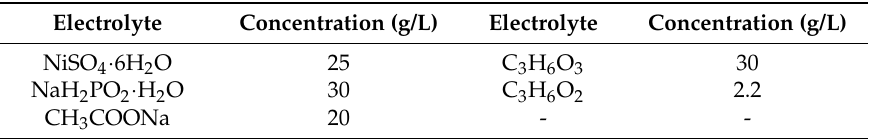
Table 1. The main composition of